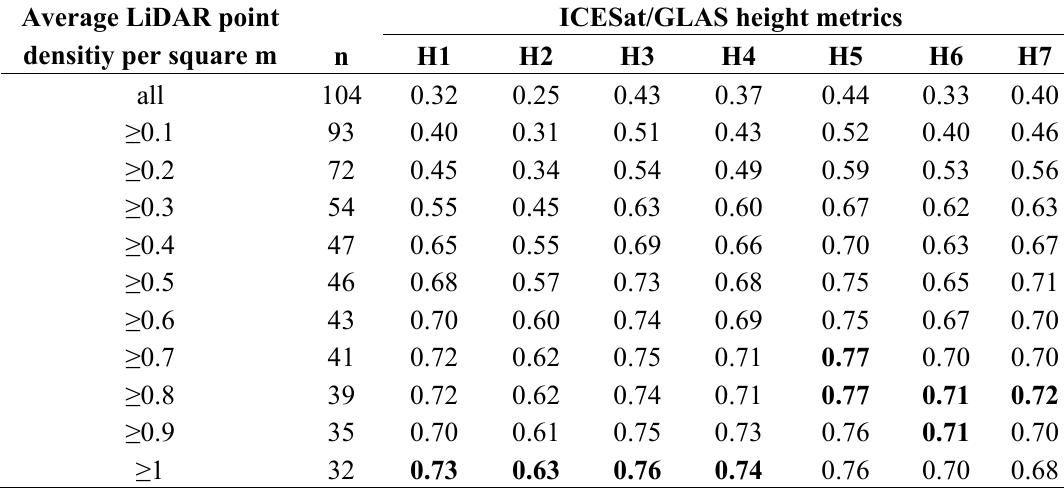
Table 3. Coefficients of determination (R 2 ) for the ICESat/GLAS height metrics (H1–H7; Figure 2) correlated to the centroid of the airborne LiDAR point cloud height histogram (CL) at the 20 m radius circular buffers at footprint center (representing the field plot size) dependent on the average LiDAR point density per square meter. Where n is the number of ICESat/GLAS footprints used for the comparison. The highest coefficients of determination (R²) are